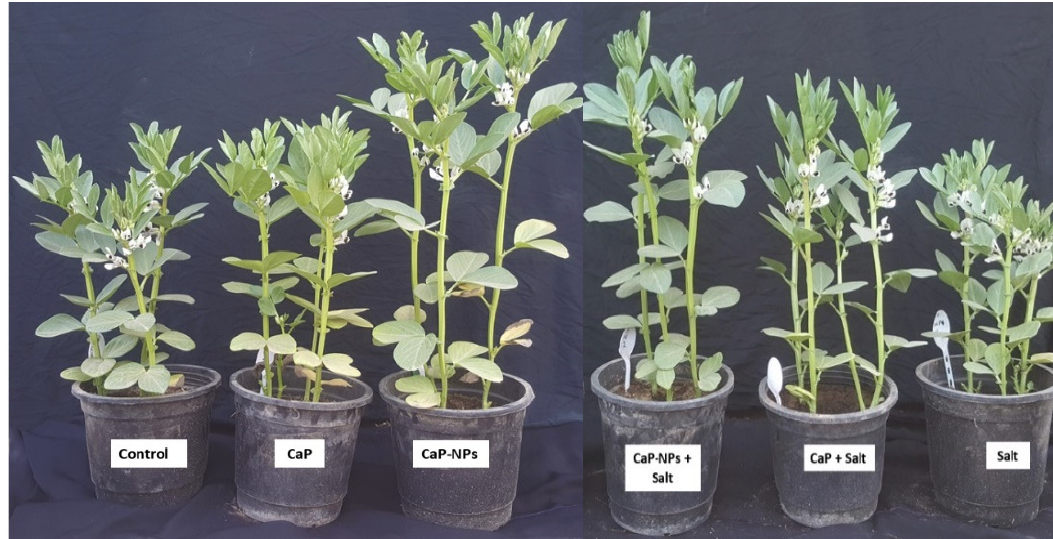
Figure 4. Effect of treatments on pods length (cm) of broad bean under salt stress.